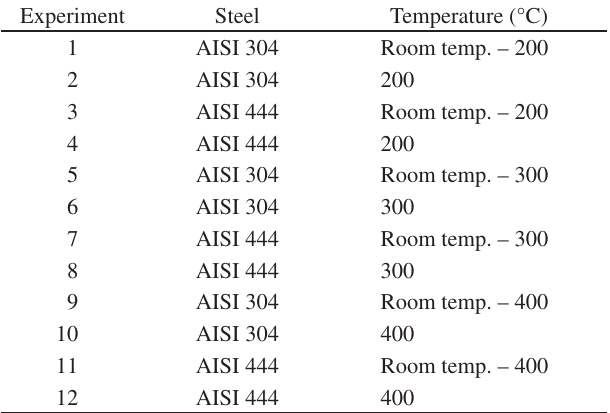
Table 2. Heat treatment in heave crude oil experiment.